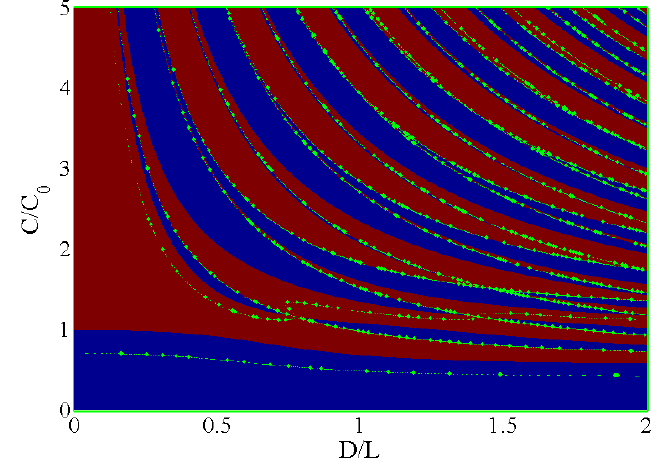
Figure 1. The sign and discontinuous point distribution of the real part of the function value ( σ =